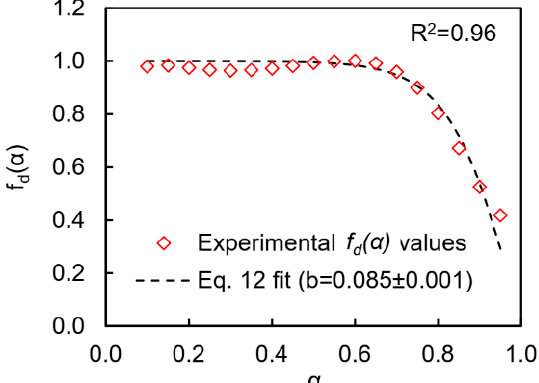
Figure 9. The diffusion factor f d ( α ) values averaged over all heating rates calculated with kinetic parameters from Table 1 (diamonds) and the best fit by Equation (12) (dashed line).